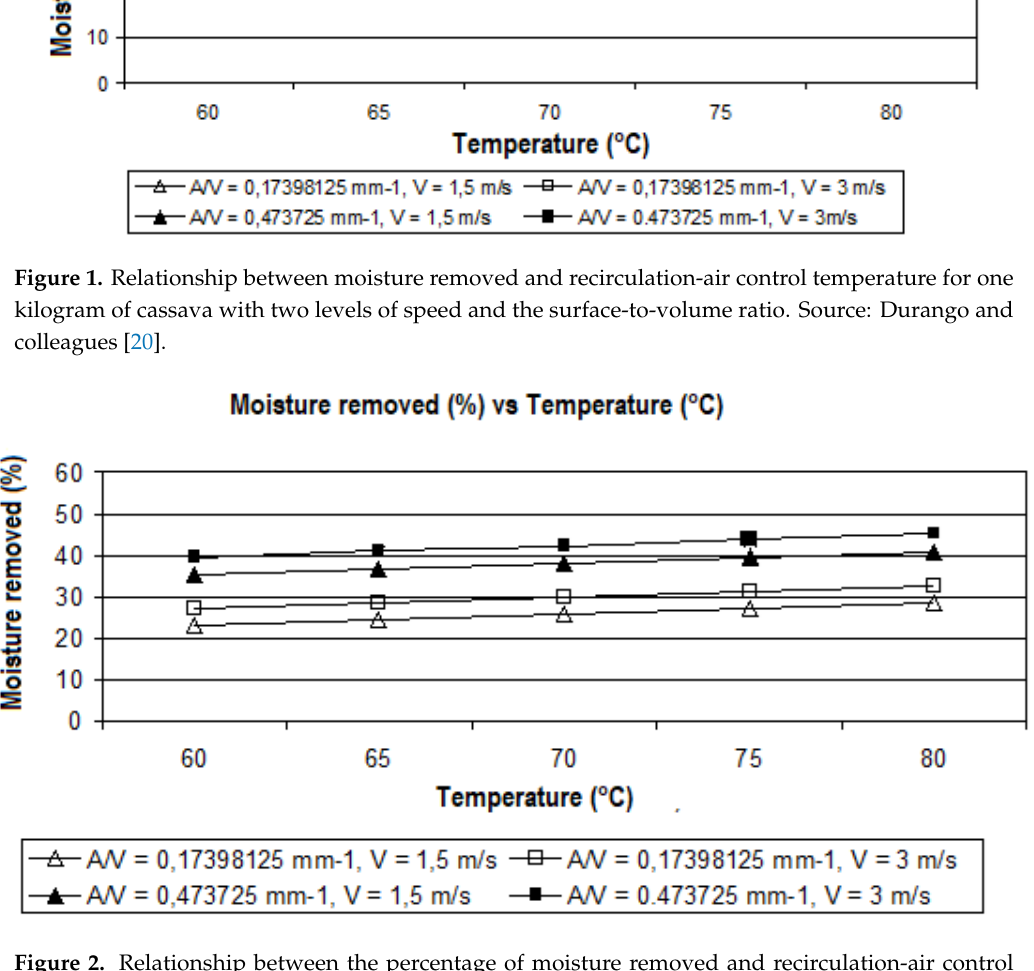
Figure 2. Relationship between the percentage of moisture removed and recirculation-air control temperature for two kilograms of cassava with two levels of speed and the surface-to-volume ratio. Source: Durango and Colleagues [20].